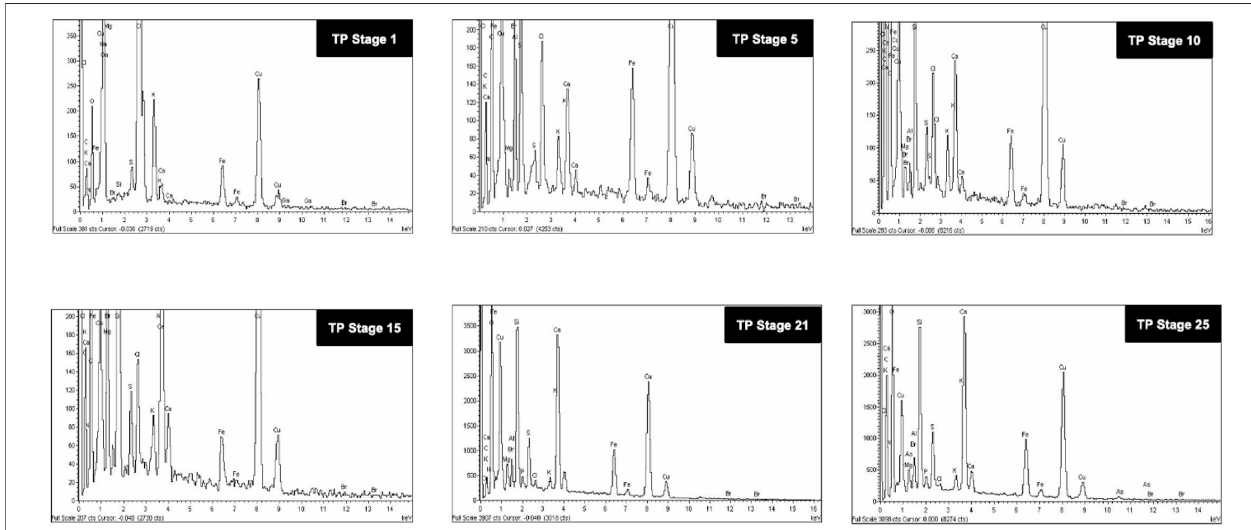
Frontiers in Bioengineering and Biotechnology |